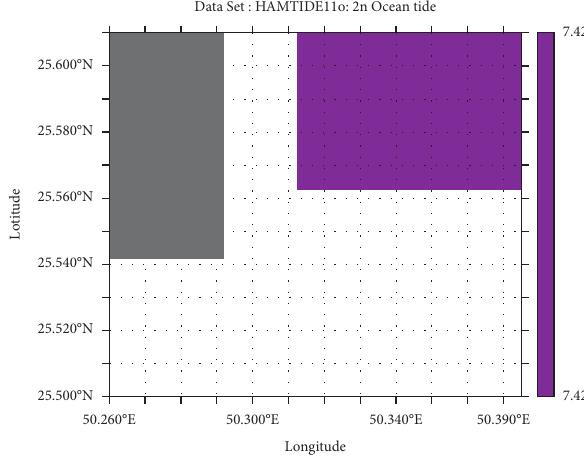
Figure 6: Amplitude in cm of N